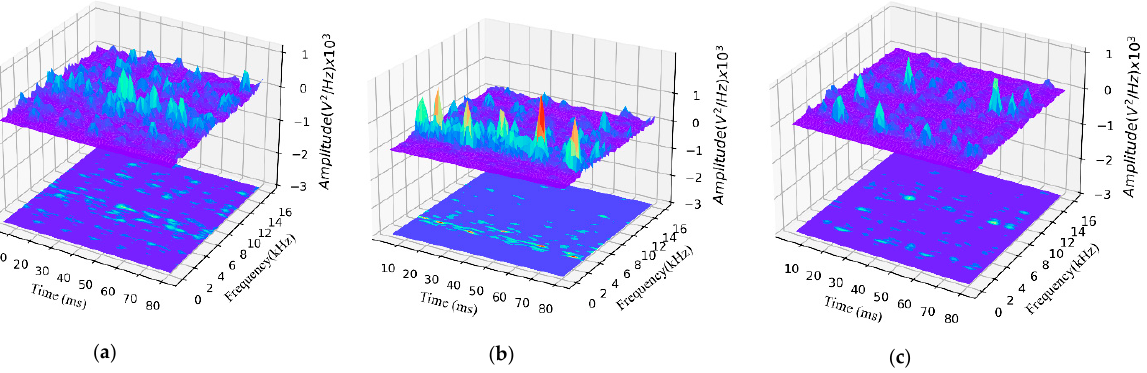
Figure 8. Time–frequency spectrum of different welding states. ( a ) Normal. ( b ) Burn-through. ( c ) Lack of fusion.